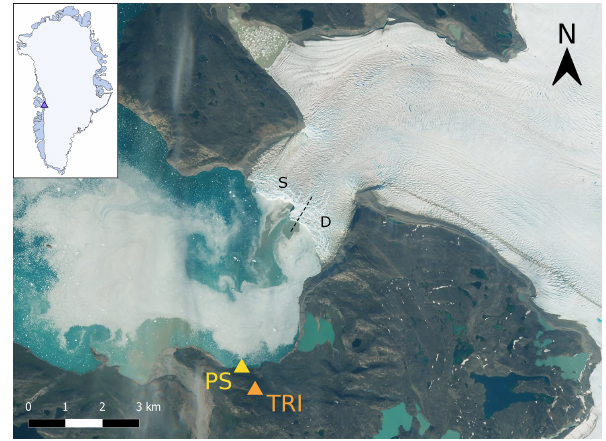
Figure 1. Eqip Sermia in West Greenland flows into a shallow fjord. Clearly visible are freshly calved icebergs and drifting ice debris pushed out by the brownish meltwater plume (under the letter S). The positions of the terrestrial radar interferometer (TRI) and the pressure sensor (PS) are indicated by orange and yellow triangles. Sectors ending in shallow (S) and deep (D) waters are separated by a black dashed line at the calving front. Background: Sentinel-2A scene from 19 July 2018 (Copernicus Sentinel data 2018, processed by